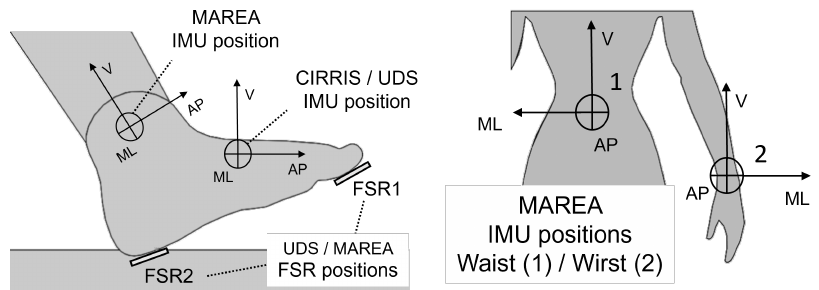
Figure 2. IMU and FSR positioning for the three databases. In CIRRIS tests, the IMU was placed outside the shoes using straps. For MAREA tests, the three IMU were attached with straps at the three positions shown, and the FSR were placed into the shoe soles. In UDS tests, the IMU and the FSR were placed on a sock inside the shoes. The orientations are defined as the antero-posterior (AP), the medio-lateral (ML) and the vertical (V)